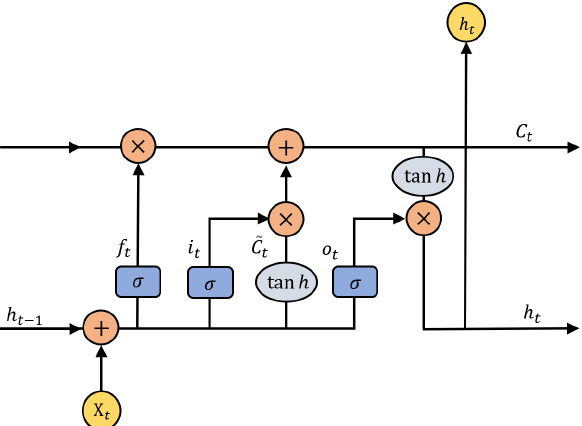
Figure 3. Standard structure of LSTM